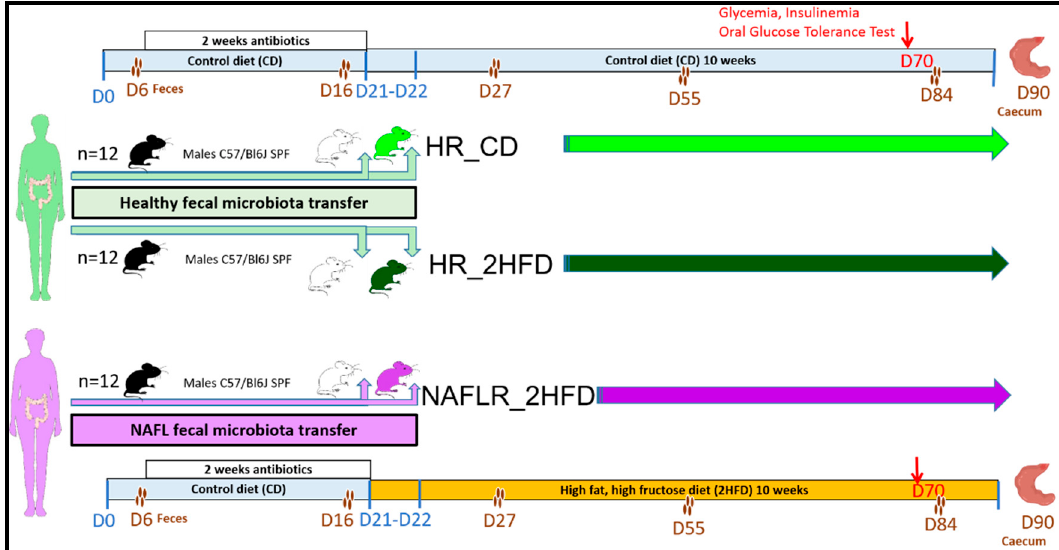
Figure 1. Design of the mouse experiment. The experiment was performed on three groups each composed of 12 specific pathogen-free (SPF) C57BL/6J male antibiotic-treated mice: (1) healthy microbiota receiver on control diet (HR_CD) group; (2) healthy microbiota receiver on high-fructose, high-fat diet (HR_2HFD) group; (3) NAFL microbiota receiver on 2HFD (NAFLR_2HFD) group. HR, healthy human microbiota receiver mice; CD, control diet; 2HFD, high-fructose, high-fat diet; NAFLR, NAFL patient microbiota receiver mice; green woman, healthy microbiota donor; purple woman, NAFL microbiota donor; black mice, SPF mice; white mice, antibiotic-treated mice; light green mice, HR_CD mice, HR mice on CD; dark green mice, HR_2HFD mice, HR mice on 2HFD; purple mice, NAFLR_2HFD mice, NAFLR mice on 2HFD. Four brownish dots, mice feces harvest; D, day; D0, mice arrival; D6, basal SPF mice feces harvest; D16, feces harvest after 2 weeks antibiotic treatment; D21-D22, two human fecal microbiota transplants (FMTs) at 24-h intervals; D27, one week after FMT; D55, one month after FMT; D70, 7 weeks of 2HFD treatment, glycemia, insulinemia and oral glucose tolerance test; D84, two months after FMT; D90, 10 weeks of 2HFD treatment; SPF, specific pathogen-free.